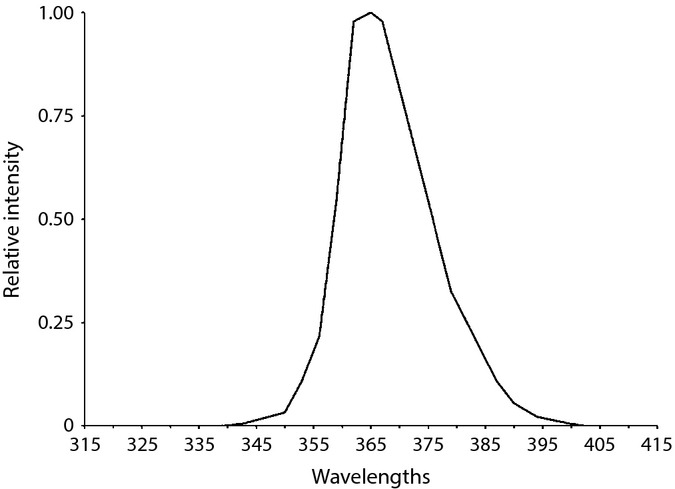
Emission spectrum of the UVA lamp. UVA irradiations were performed using B100 (UVP) lamps. The spectrum is derived from the manufacturer's specifications and modified according to measurements made using an International Light double monochromator spectroradiometer (IL7000/760D/790).